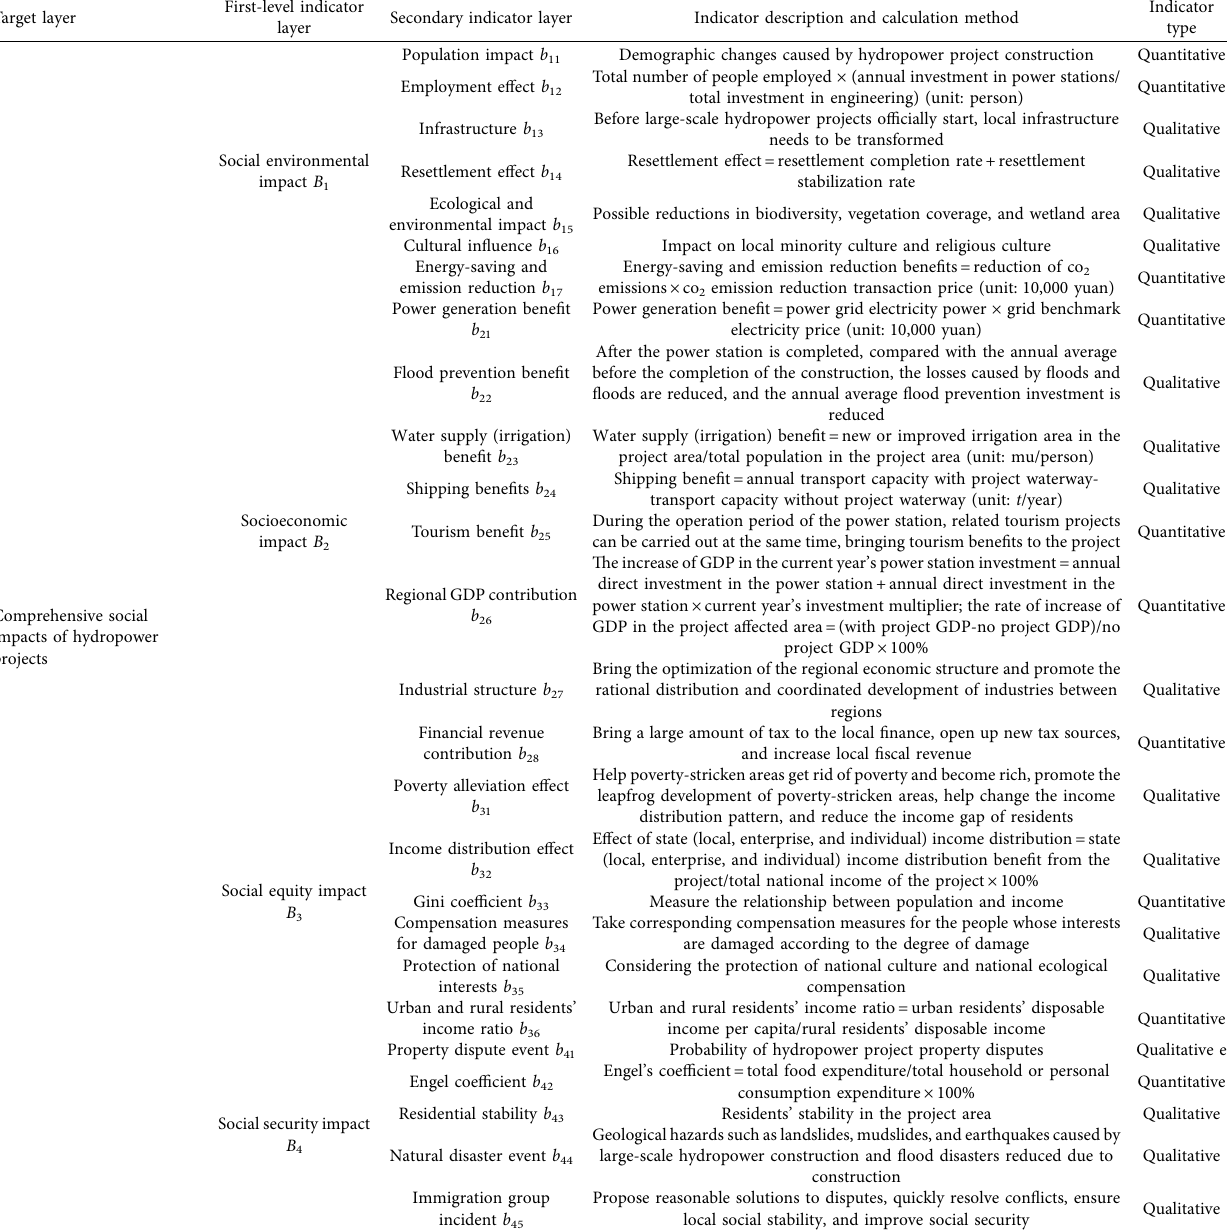
Table 1: Social impact assessment indicators of hydropower